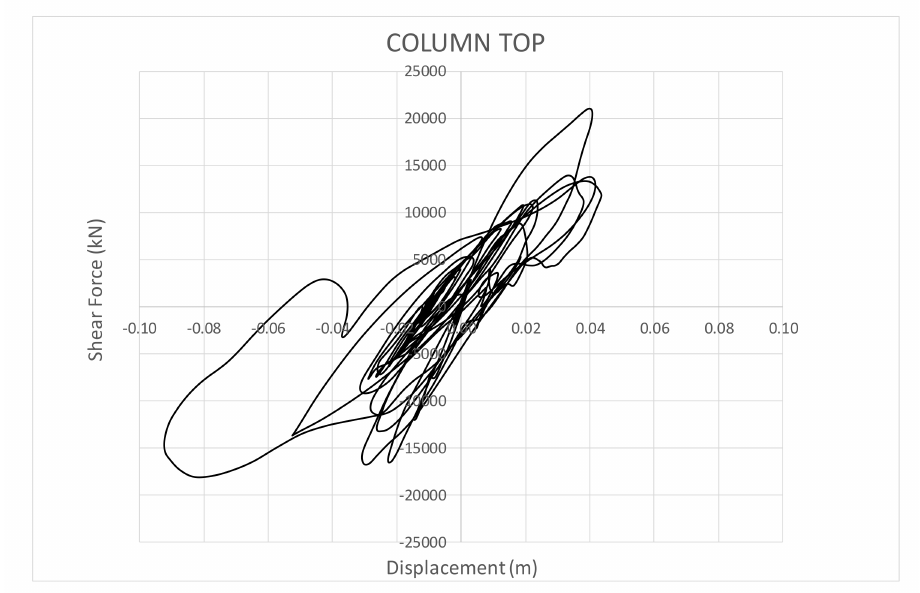
Figure 8. Displacement vs. shear force at the top of the column for the most severe earthquake.